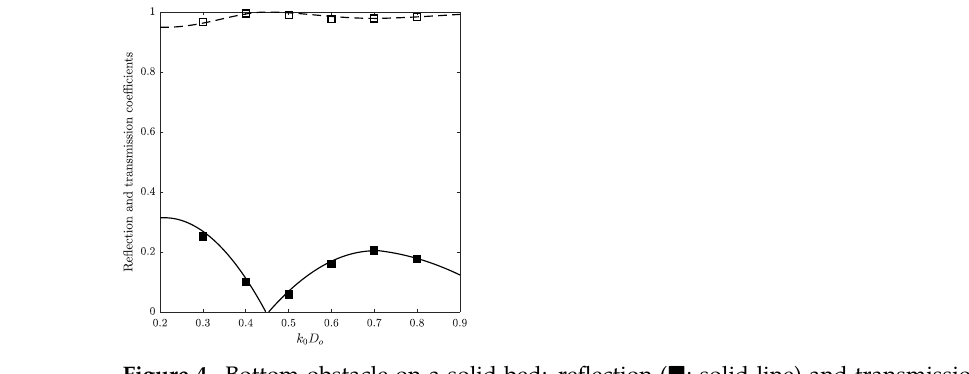
Figure 4. Bottom obstacle on a solid bed: reflection ( (cid:4) ; solid line) and transmission ( (cid:3) ; dashed line) coefficients. Symbols: numerical results. Lines: existing analytical predictions [7]. k 0 is the wavenumber of incident waves. In this example, ( d , D o , L o , d m ) = ( 0.8,0.4,0.4,0 ) m. See Figure 1b for the problem